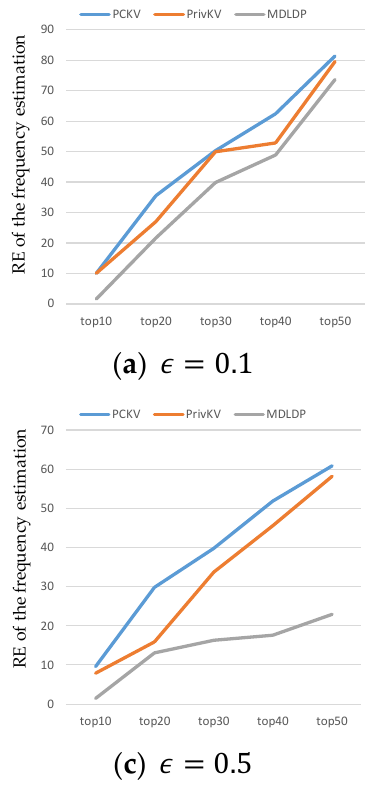
Figure 11. RE of the frequency estimation with different 𝛜 .